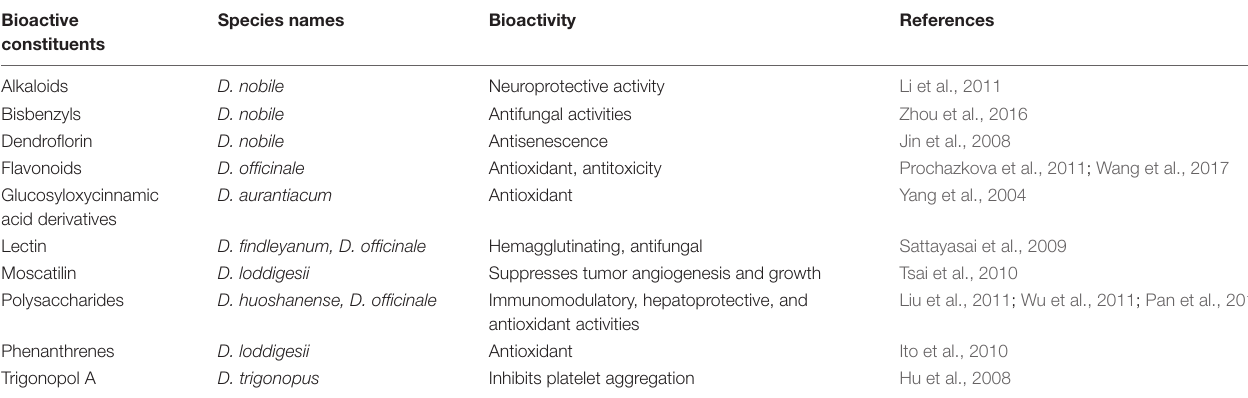
TABLE 1 | The effective components and their bioactivities in medicinal Dendrobium.